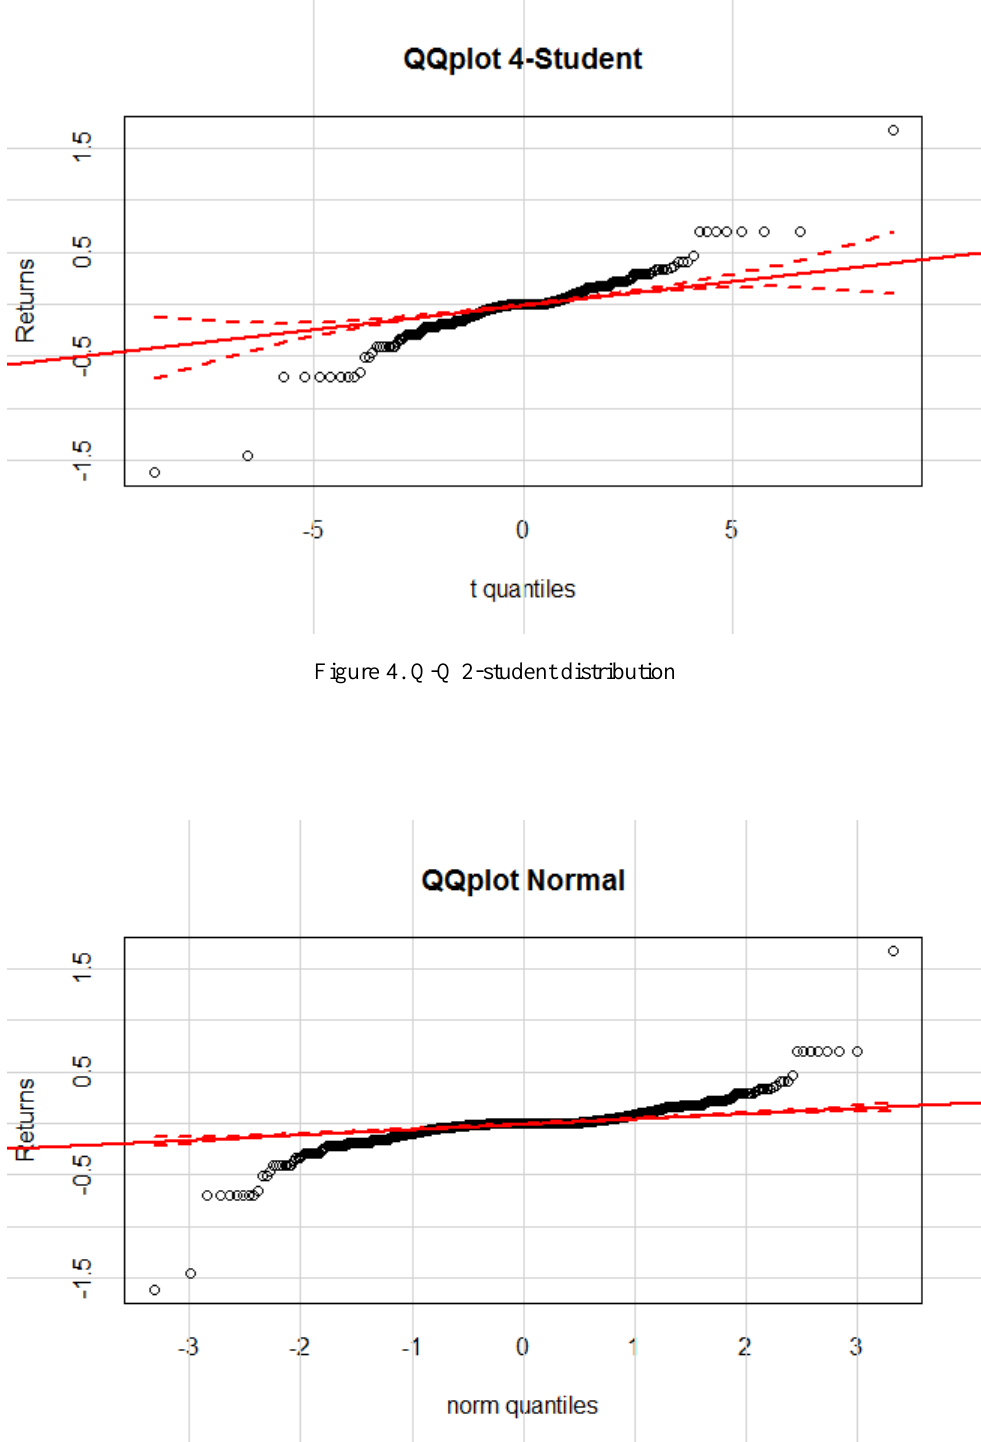
Figure 5. Q-Q 4-student